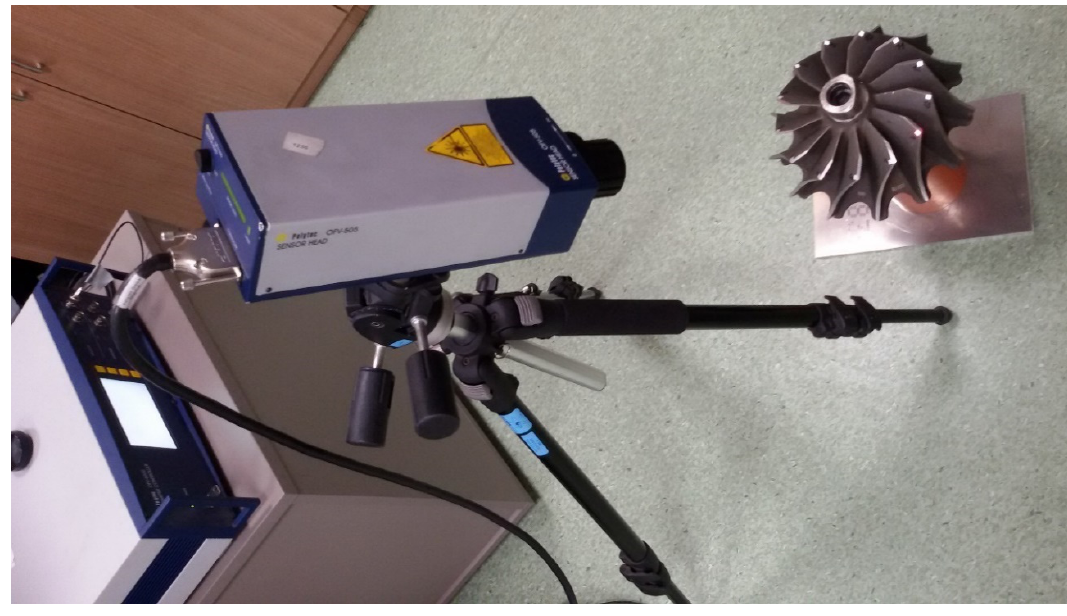
Figure 3. Laser equipment for blade vibration measurement.